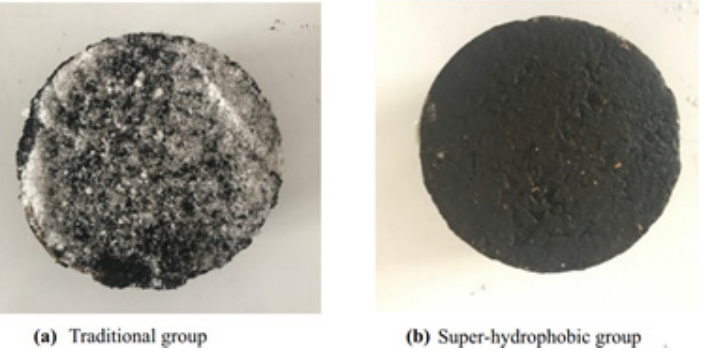
Figure 5. Morphology of the ice layer on the surfaces of the samples after the simulation of frosty conditions. Reprinted with permission from [49].